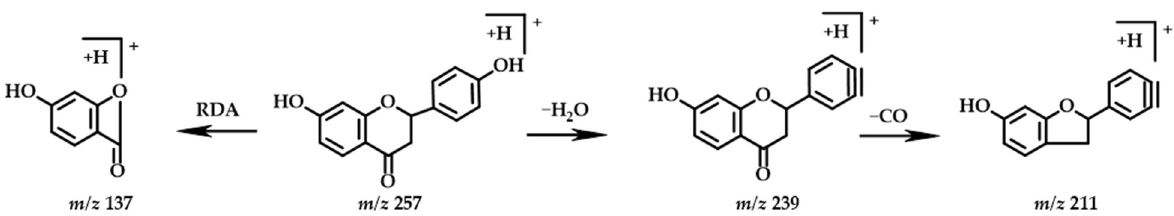
Figure 6. Chemical structure and fragmentation pathways of liquiritigenin.